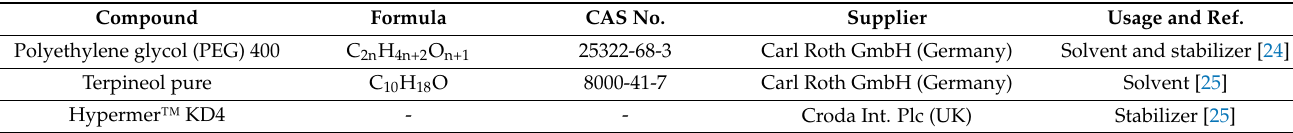
Table 1. Organics used for preparation of Ni nanopastes. Formula CAS No. Usage and